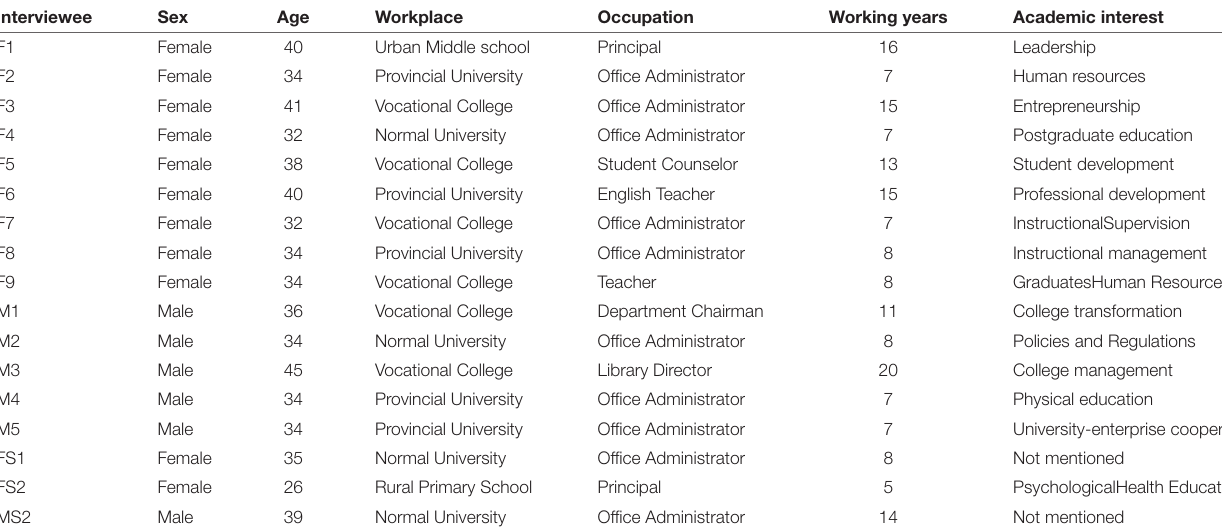
TABLE 1 | Interviewees’ demographic